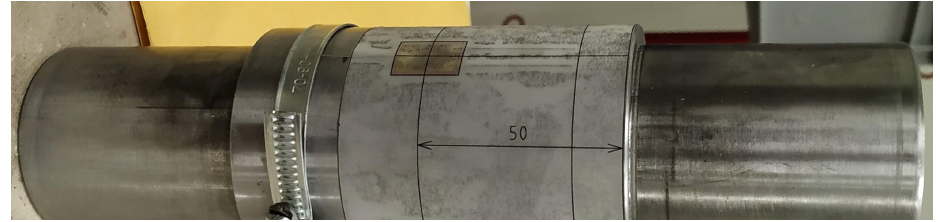
Figure 6. Strain gauges placed with high accuracy to the measuring place.